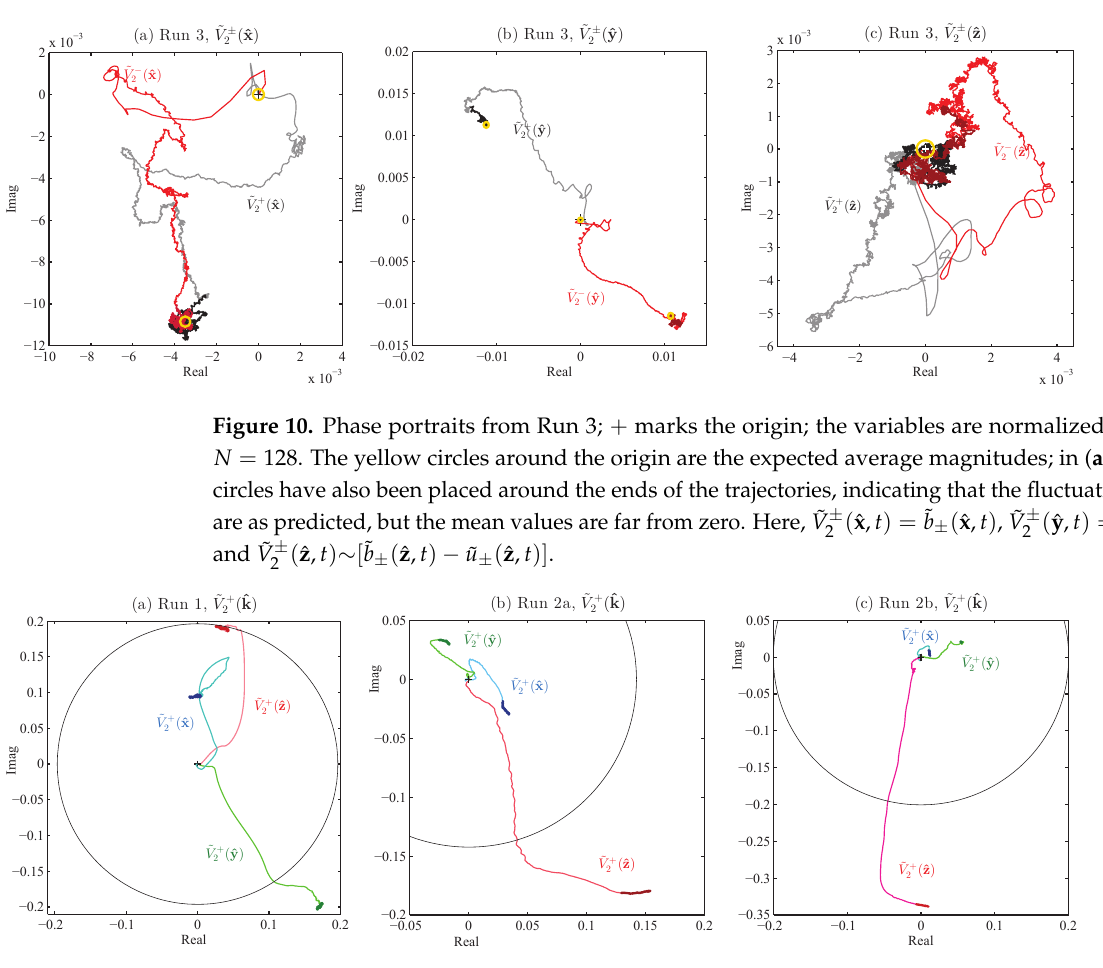
Figure 11. Phase portraits from Runs ( a ) 1, ( b ) 2a and ( c ) 2b; + marks the origin; the variables are normalized by N 3/2 , N = 128. Light parts are the full trajectory, while dark ends are from the last half of the trajectory, i.e., from 0.5 t end to t end . The black circles have radius √ H M /3. Please see Figure 12 ( ˆ k , t ) = ˜ b + ( ˆ k , t ) for close-ups of ends of trajectories in ( a ). In these figures, ˜ V + 2